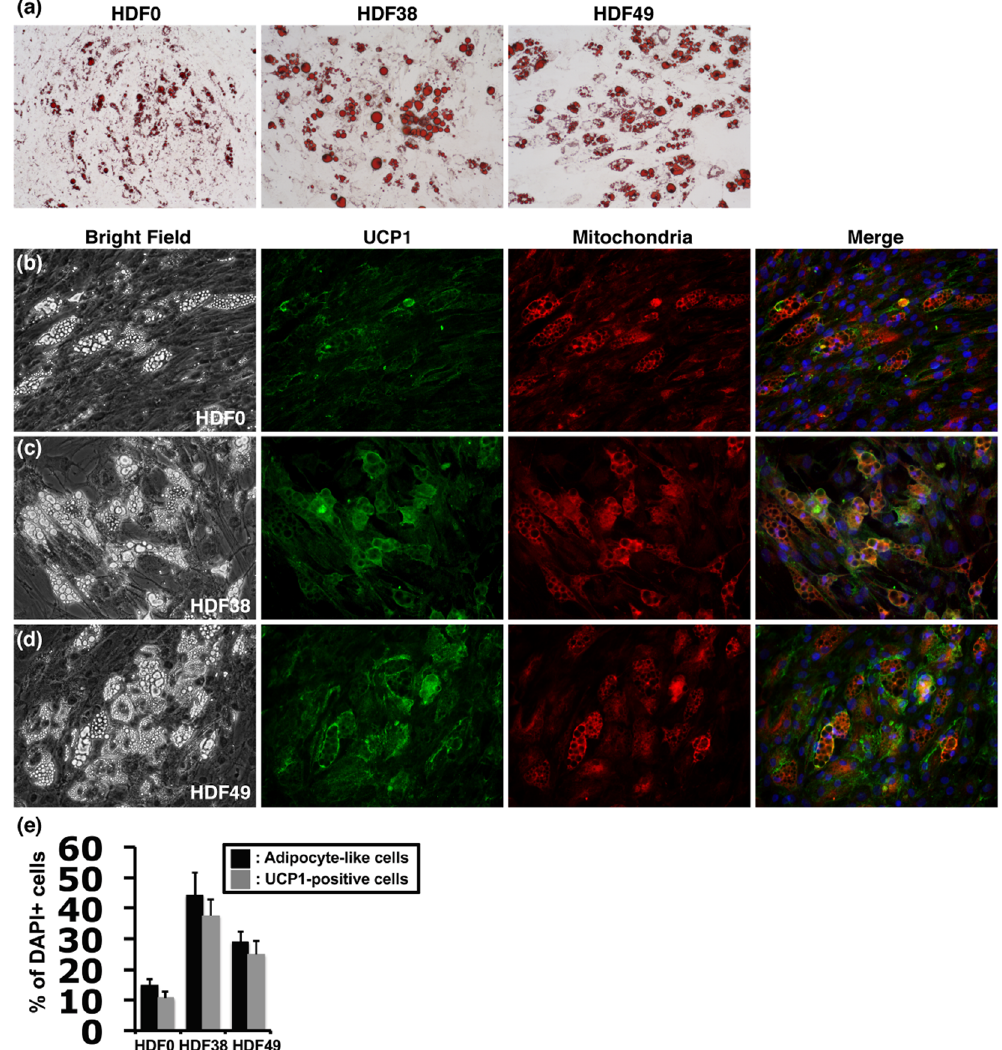
Figure 2. Chemically induced brown adipocyte-like cells exhibit a high abundance of lipid droplets and UCP1 expression along with elevated level of cellular mitochondria. The cells were induced by treatment with the adipocyte medium and 5CD-GM for 3 weeks followed by cultivation with the adipocyte medium only for 1 week. ( a ) Oil Red O staining of the adipocyte-like cells derived from the 3 lines of human fibroblasts, HDF0 (left panel), HDF38 (middle panel), and HDF49 (right panel). Images of bright field, UCP1 protein expression (green), mitochondria labelling with MitoTracker (red), and merged image of UCP1 (green), MitoTracker (red) and DAPI (blue) to visualise nuclei in the fibroblasts of HDF0 ( b ), HDF38 ( c ), and HDF49 ( d ). ( e ) To evaluate the efficiency of direct conversion by 5CD-GM, the numbers of DAPI-positive cells, adipocyte-like cells with lipid droplets, and UCP1-positive cells were counted in the 3 lines of human fibroblasts, HDF0, HDF38, and HDF49 (n = 3). Data represent mean ±